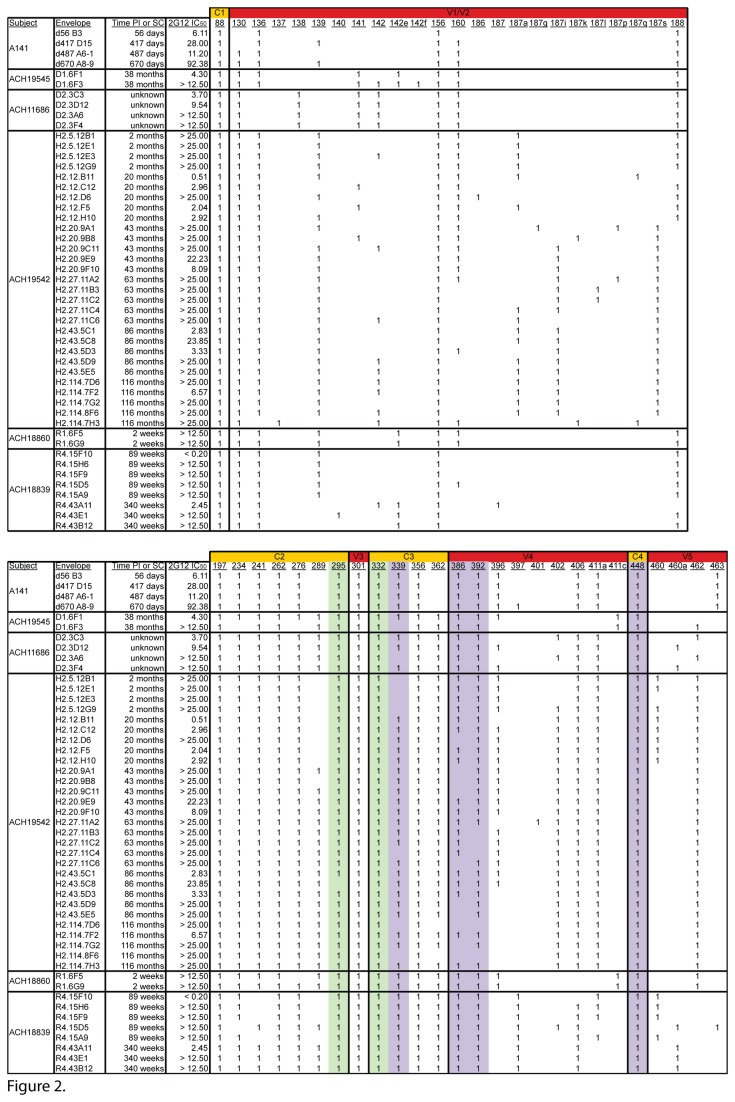
PNGS changes in different clade B Env quasispecies.Regions of Envelope are noted in the top bar and below are the PNGS positions. All protein sequences were aligned to HXB2 (accession # AF033819) and were analyzed with the Aminotrack webserver (http://apps.sbri.org/AminoTrack/). 1: Presence of PNGS at a given amino acid position. Green boxes indicate the essential PNGS and purple boxes indicate the accessory PNGS for 2G12 recognition. 2G12 IC50 (µg/mL) and the time post infection (PI) for the envelopes from the A141 macaque are indicated. Neutralization data and time since seroconversion (SC) for subjects ACH19545, ACH11686, ACH 18860 and ACH18839 from the Amsterdam cohort are reported per Quakkelaar et al. [24]. 2G12 IC50 (µg/mL) and time since SC for subject ACH19542 from the Amsterdam cohort are adapted from Bunnik et al. [23]..